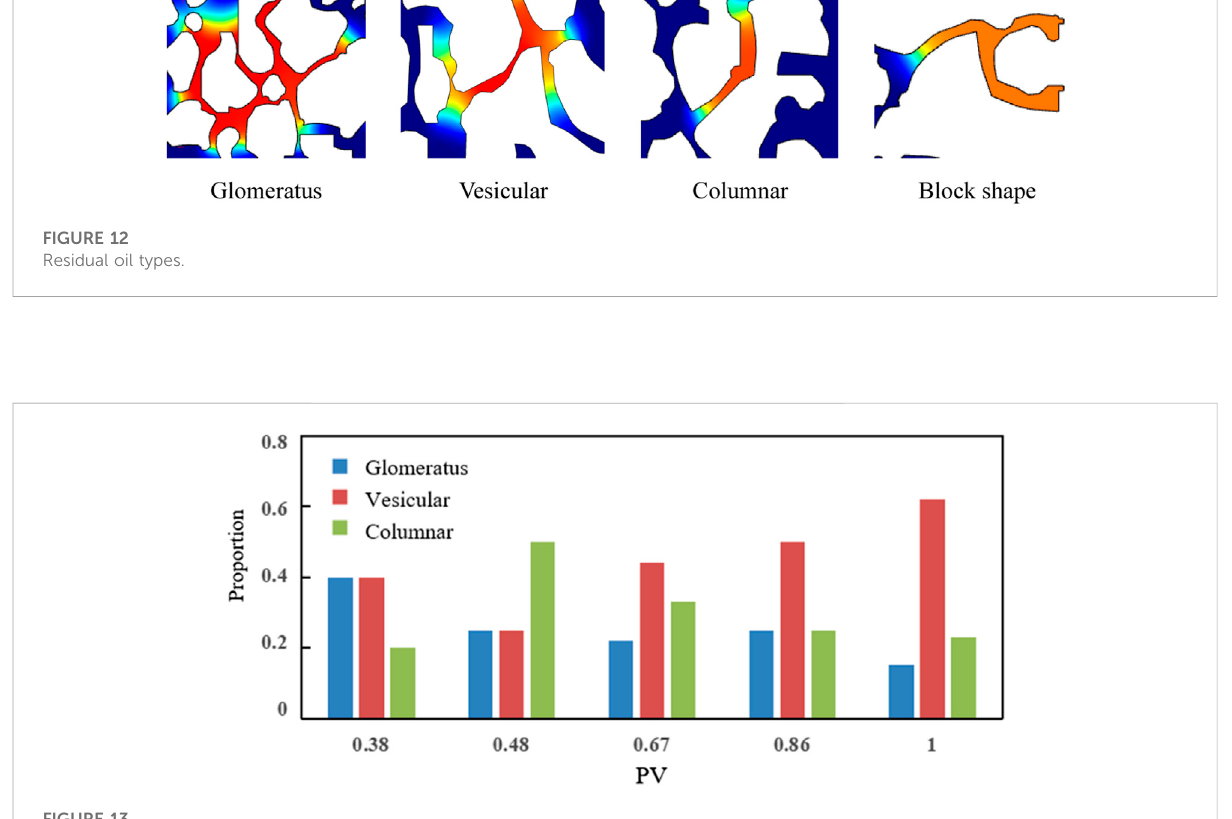
FIGURE 13 Residual oil distribution according to the matrix type.